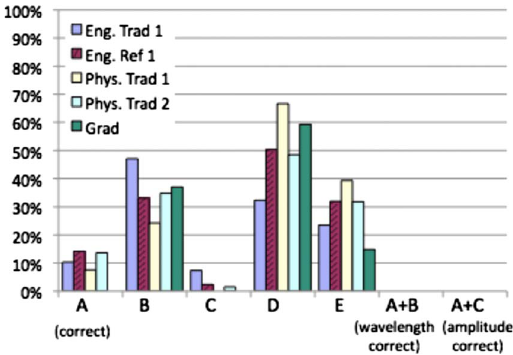
FIG. 8. (cid:1) Color (cid:2) Responses to the original slanted well question shown in Fig. 7 for students in four modern physics classes and for graduate